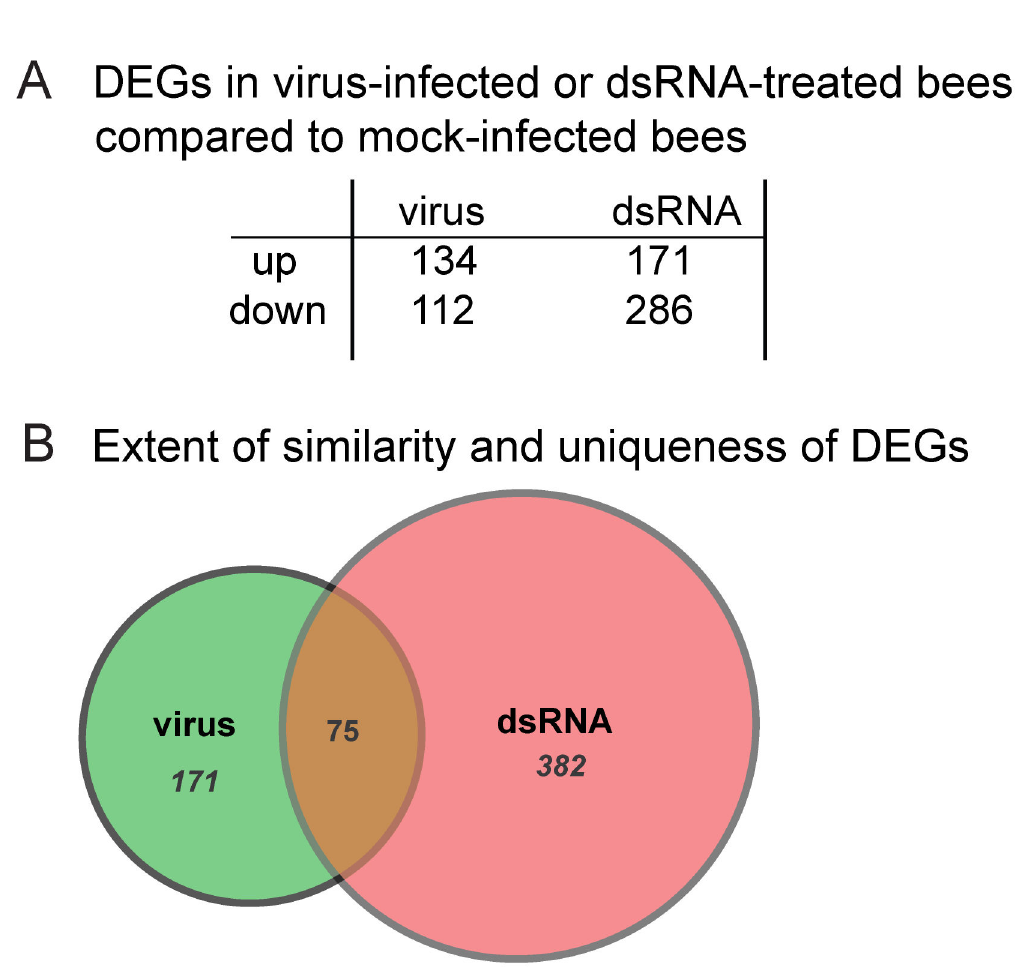
Figure 3. Differentially expressed honey bee genes. (A) Table of differentially expressed genes (DEGs) in virus-infected or dsRNA-treated bees as compared to mock-infected bees (adj. p-value < 0.05); the number of genes with increased (up) and decreased (down) expression are listed below each condition. (B) Venn diagram illustrating the degree of similarity and uniqueness of DEGs (adj. p-value < 0.5) between virus-infected (virus) and dsRNA-treated bees